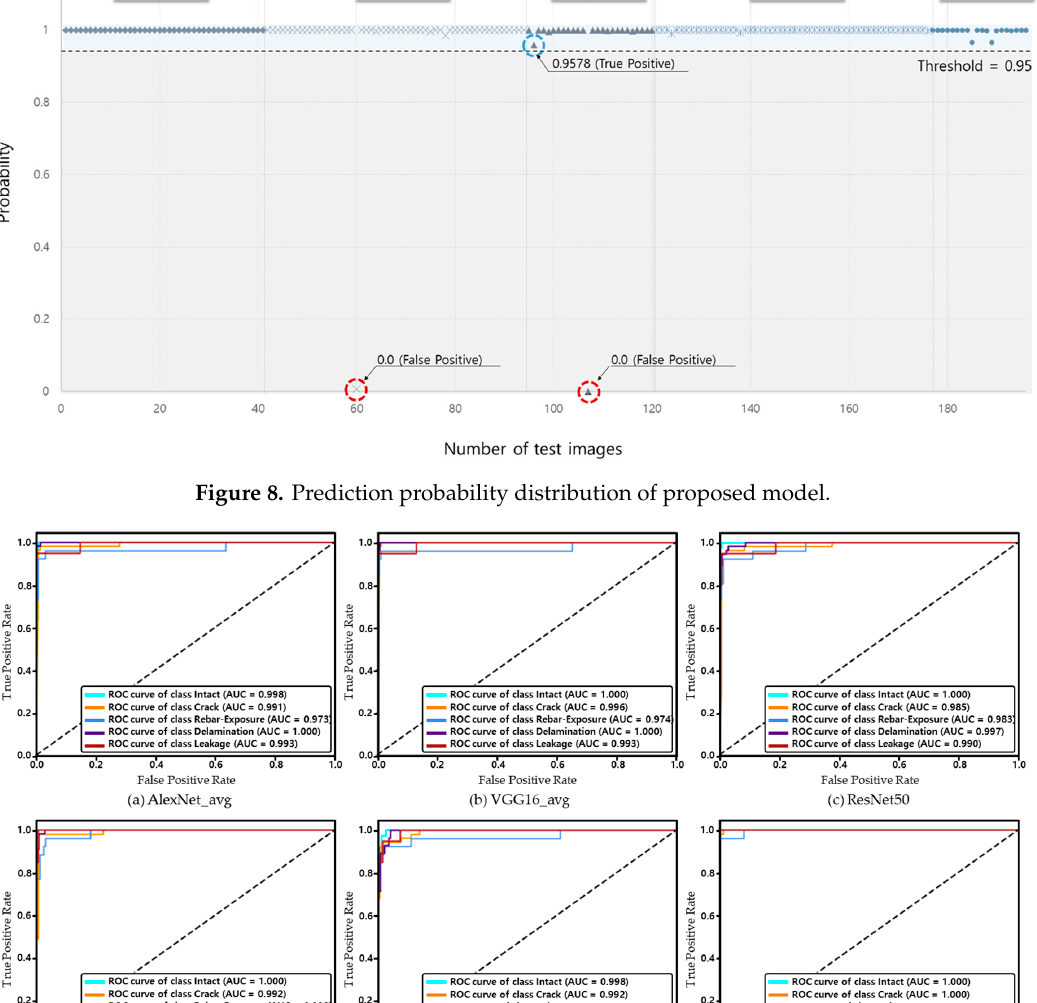
Figure 8. Prediction probability distribution of proposed model.